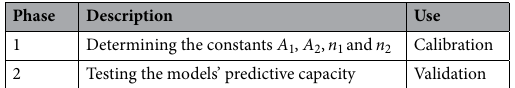
Table 4. The experiments used for models’ calibration and